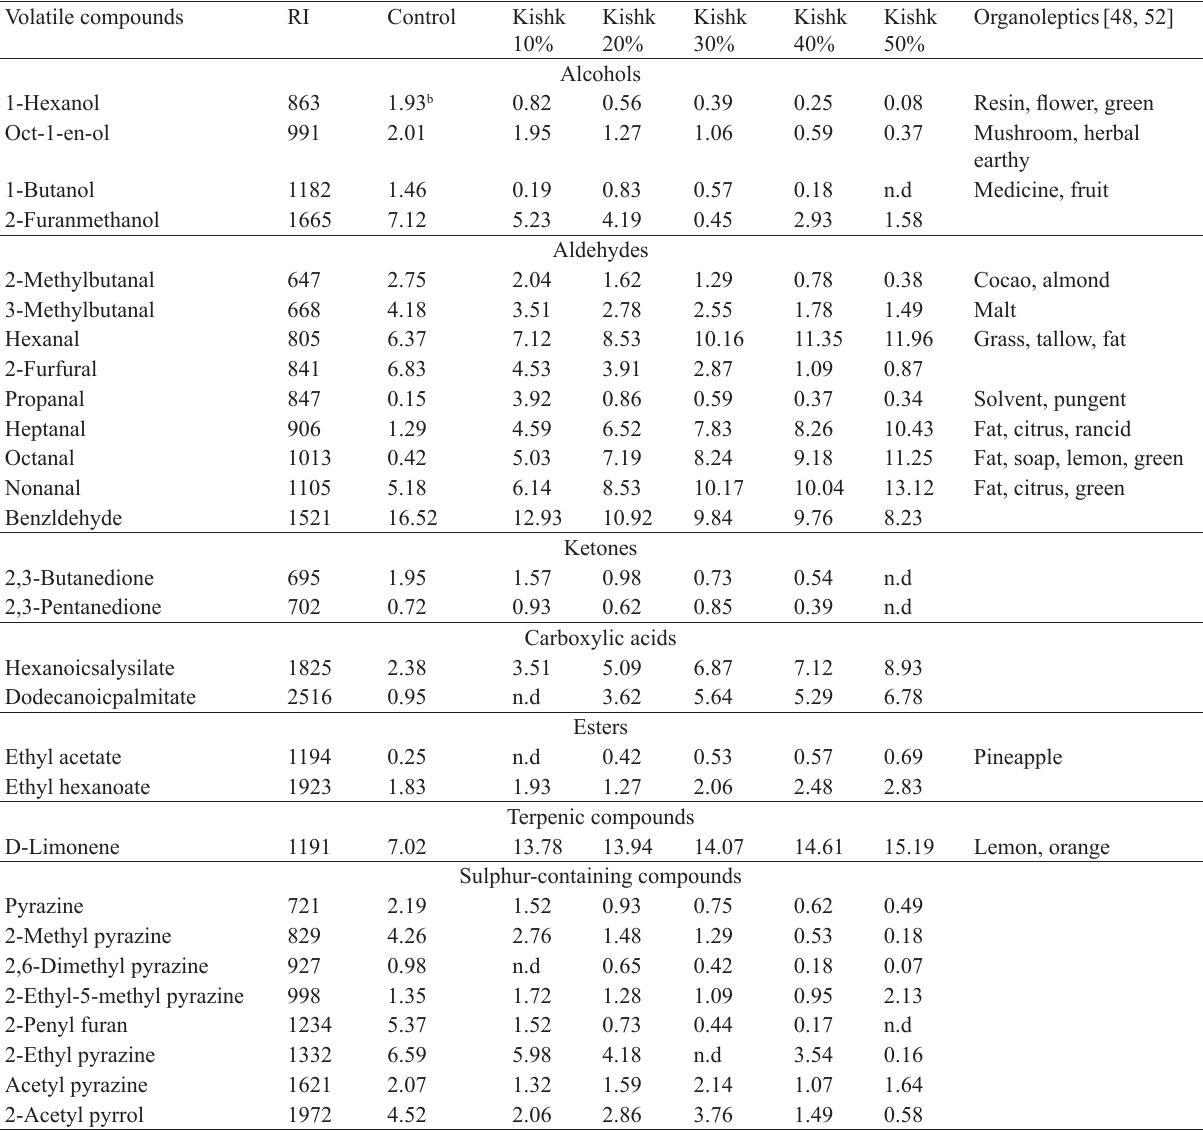
Table 7 Volatile compounds of biscuit fortified with Egyptian kishk Volatile